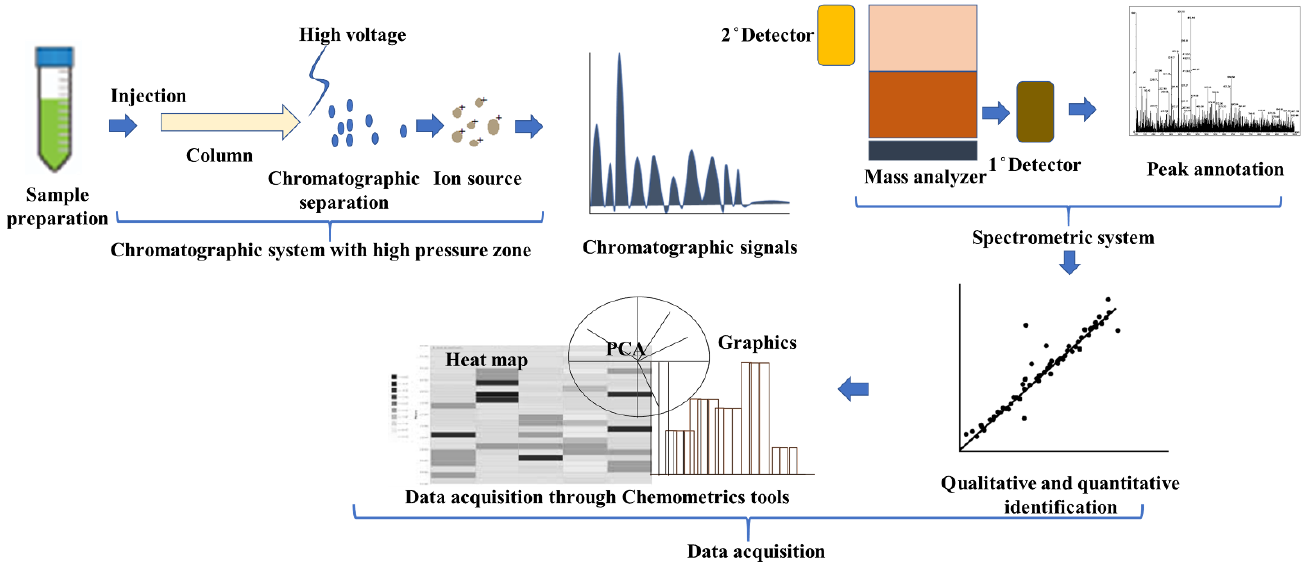
Figure 1. A systematic approach for metabolomic analysis and data acquisition analysis through statistical tools for medicinal plants and their derived products. statistical tools for medicinal plants and their derived